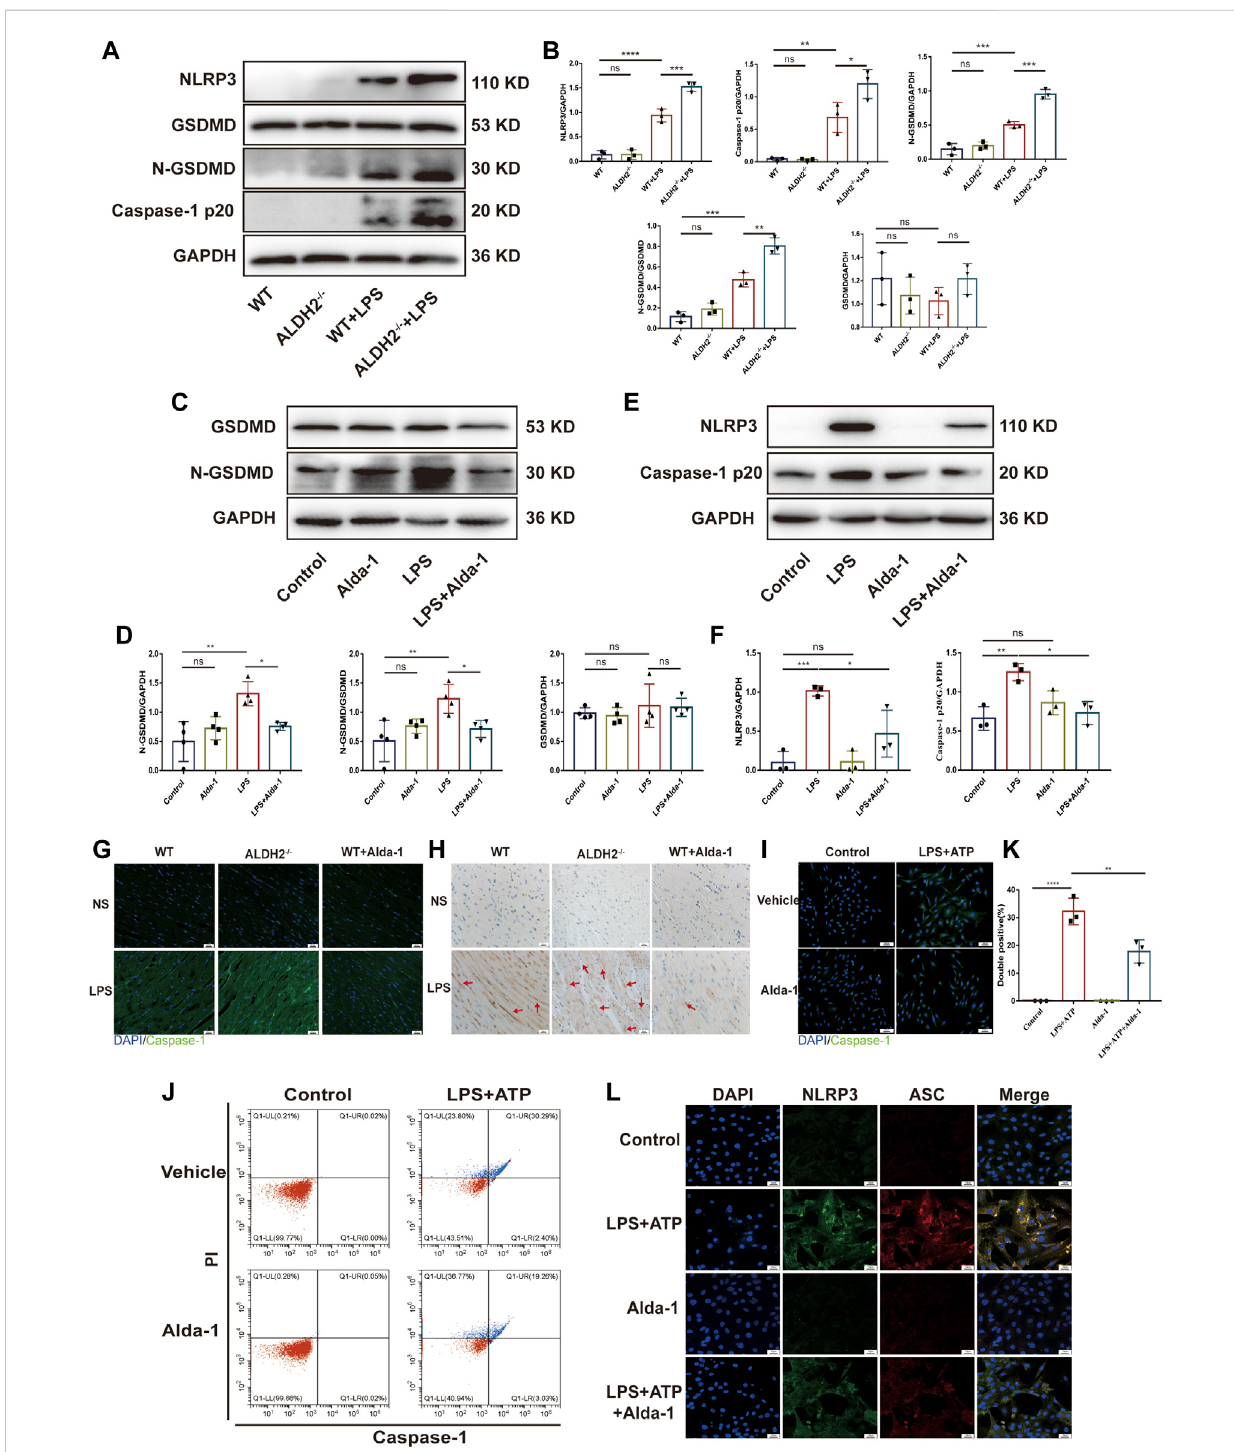
FIGURE 3 ALDH2 inhibits myocardial pyroptosis through NLRP3/Caspase-1/GSDMD signaling pathway. (A-F) Representative immunoblots and quanti fi cation of N-GSDMD, GSDMD, NLRP3 and caspase-1 p20 protein in LPS-stimulated Aldh2 − / − and WT mice (GAPDH; loading control), n = 3-4 per group. (G) Representative immuno fl uorescence tissue images showing caspase-1 (green) and DAPI (blue), scale bar: 50 μ m. (H) Representative immunohistochemical imagesshowing caspase-1 (brown), scale bar:50 μ m. (I – L) H9C2cells were stimulated byLPS plusATP with or without pre- treated Alda-1. (I) Representative immuno fl uorescence images showing caspase-1 (green) and DAPI (blue), scale bar: 100 μ m. (J,K) Representative fl ow cytometry graphs showing positive-caspase-1/PI double staining and the quantitative analysis of the double positive, n = 3 per group. (L) Representative immuno fl uorescence images showing NLRP3/ASC speck, scale bar: 25 μ m. Mean ± SEM. **** p < 0.0001; *** p < 0.001; ** p < 0.01; * p < 0.05; ns = not signi fi